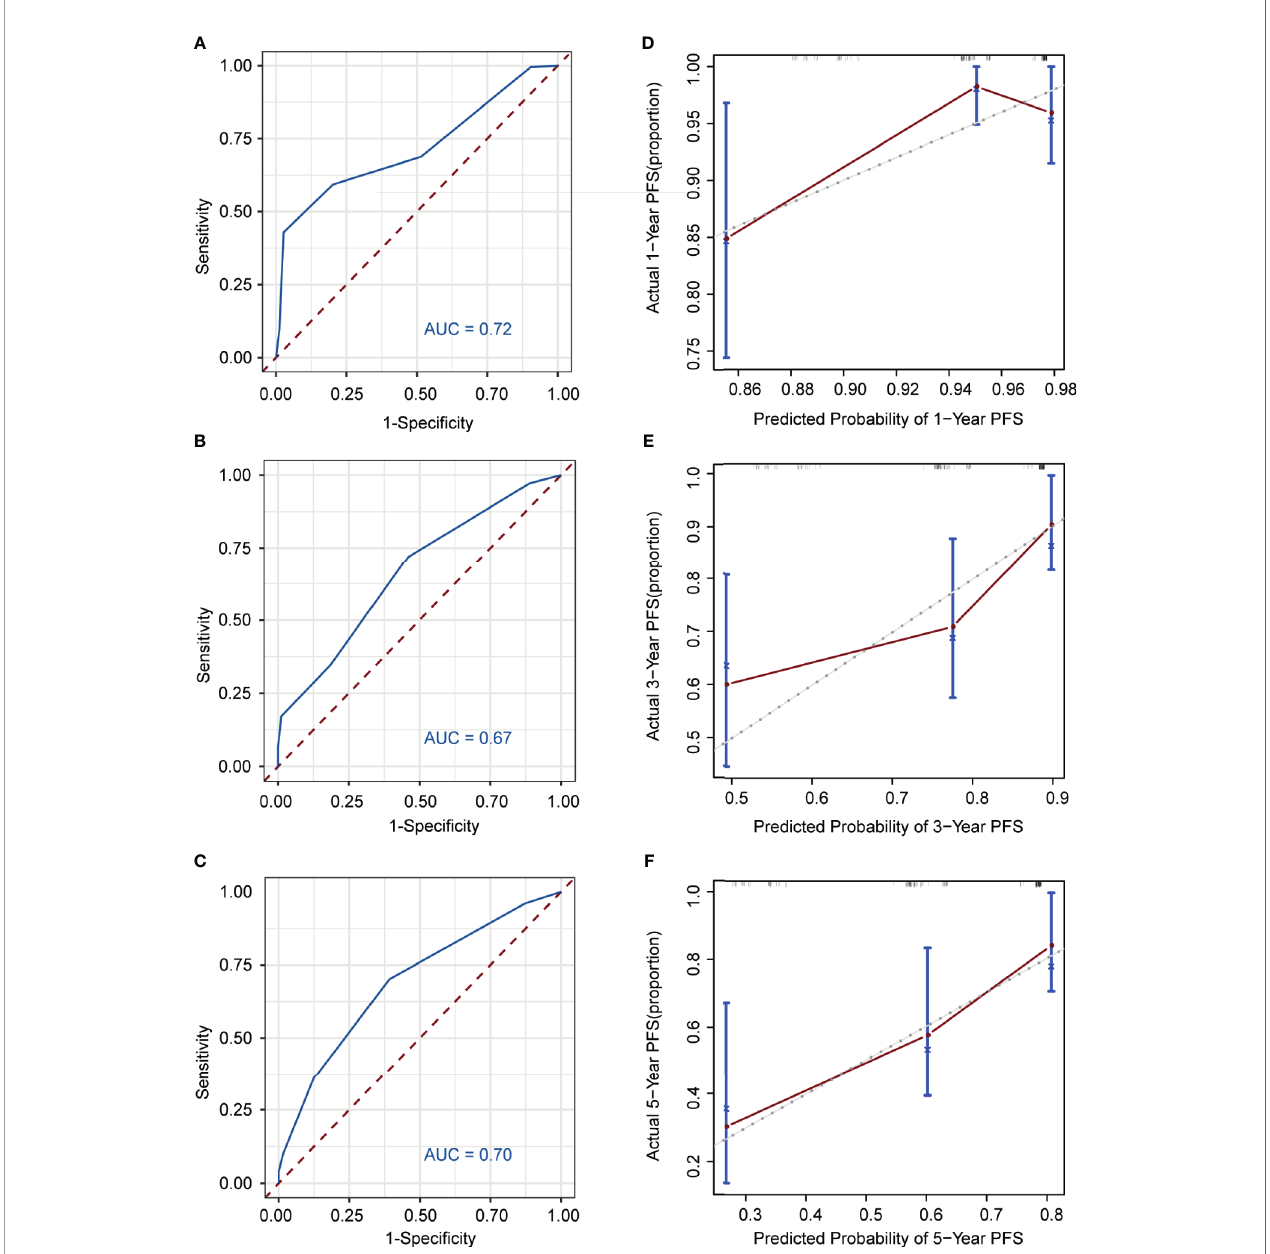
FIGURE 3 | Discrimination and calibration of the nomogram to predict 1, 3, 5-year PFS likelihoods in patients with follicular lymphoma. The area under the receiver operating characteristic (ROC) curve (AUC) and the calibration curve for the prediction of 1-year PFS (A, B) , 3-year PFS (C, D) , 5-year PFS (E, F) ; The PFS probability predicted by, the nomogram is plotted on x-axis; while the actual PFS is plotted on the y